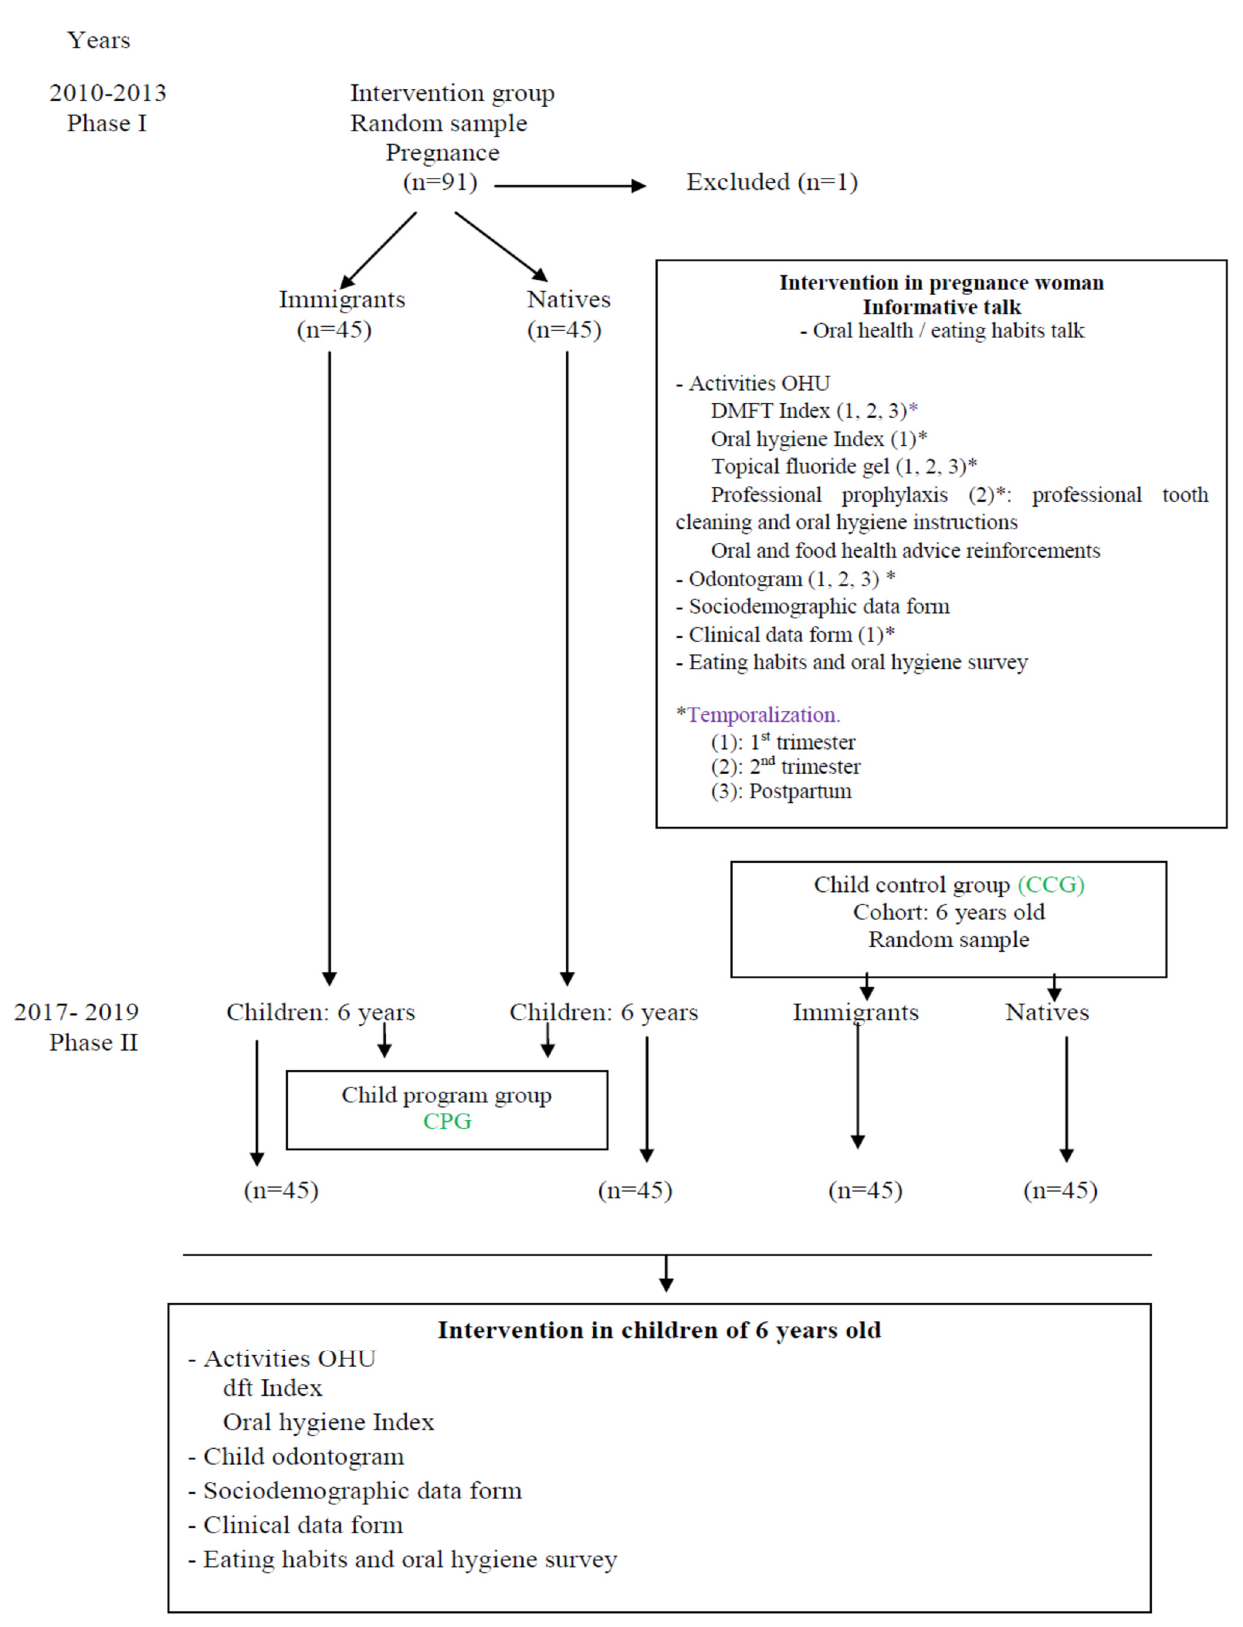
Figure 1. Study design. Flow diagram of the participants. DMFT: decayed, missing, filled teeth. dft: decayed, filled teeth. OHU: Oral Health Unit. CPG: Child program group. CCG: Child control group.